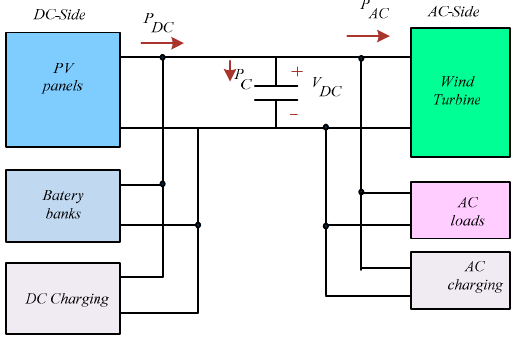
Figure 7. DC power flow diagram.